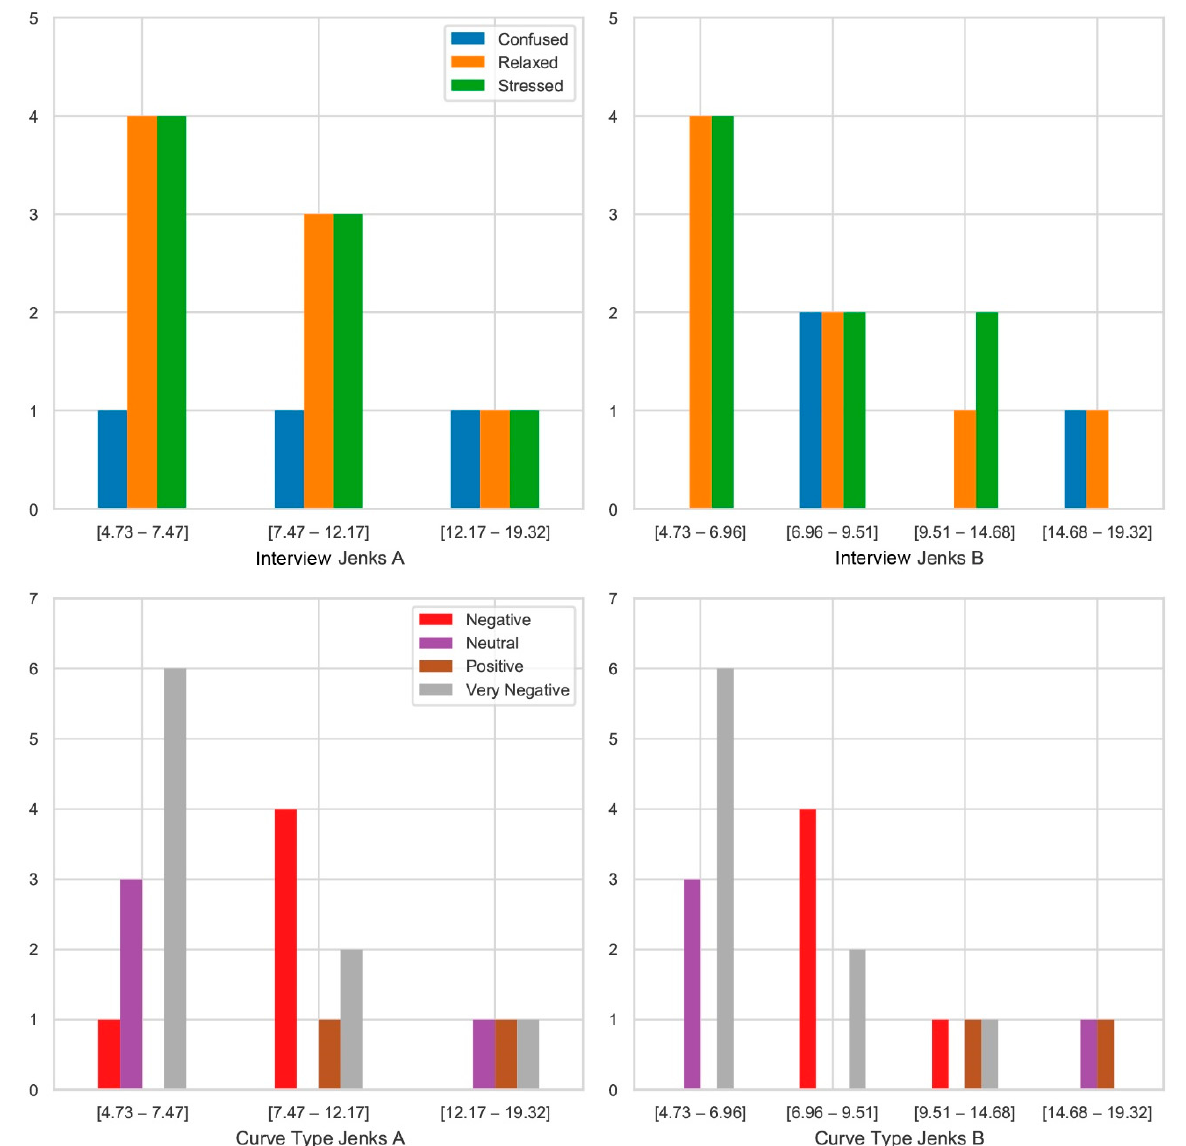
Figure 8. Jenks method cluster using three ( right ) and four ( left ) clusters. The top row show clusters of the groups from the interview data and the bottom row shows clusters of the curve types. The x-axis shows clusters and their ranges in seconds and the y-axis shows how many participants each cluster is populated by.